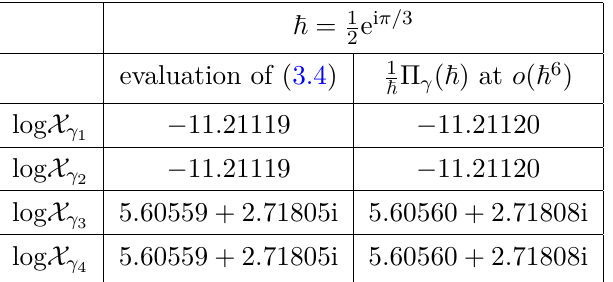
= u = 0 and Λ = 1 1 2